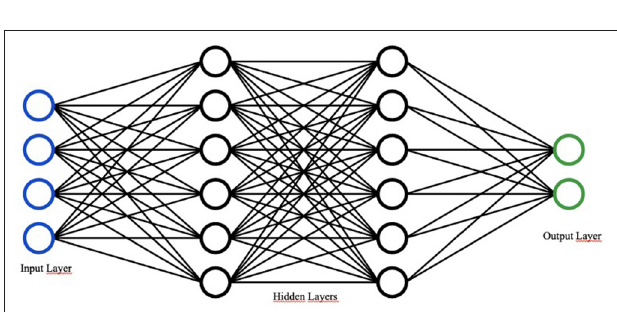
FIGURE 2 | Basic design of a neural network. Adapted from “Network.svg” by Victor C. Zhou